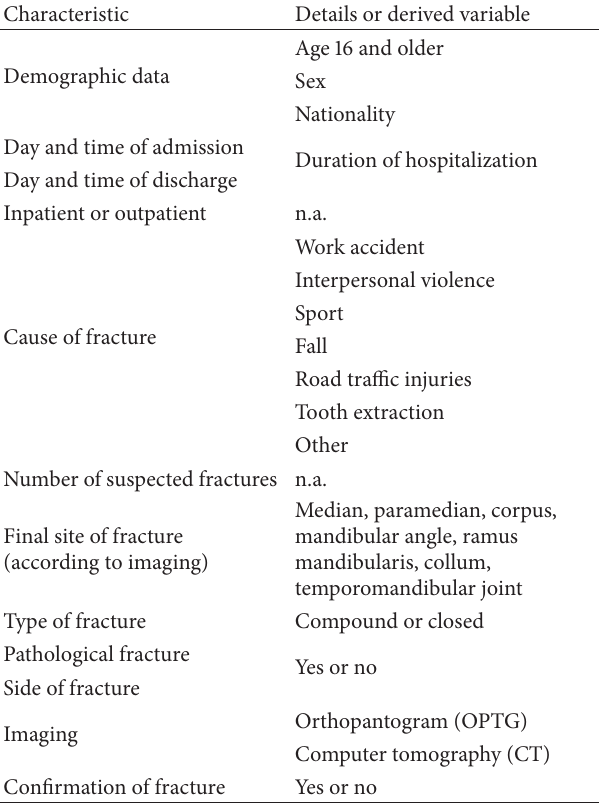
Table 1: Characteristics of patients admitted to the emergency department with mandibular fracture.